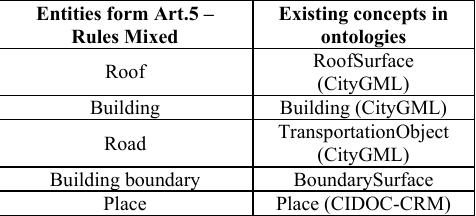
Table 4. Comparing concepts among regulations and ontologies.